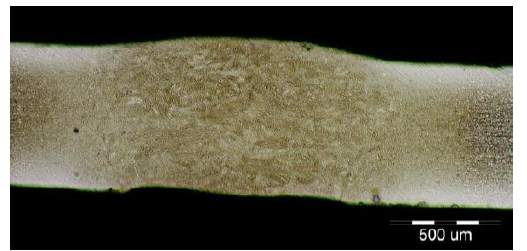
Figure 11. Macrostructure of the welded joint sample B (DP600).